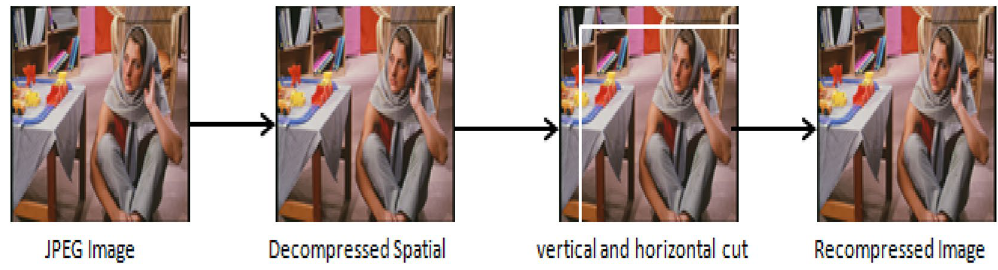
Figure 12. Diagram explaining the calibration